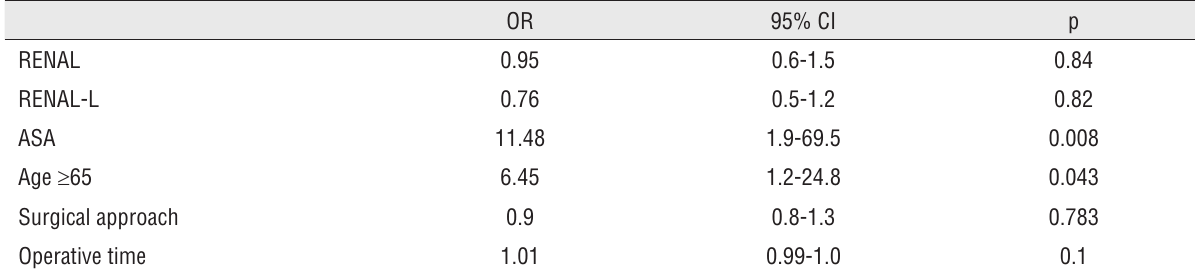
Table 5 - Predictors of clavien ≥